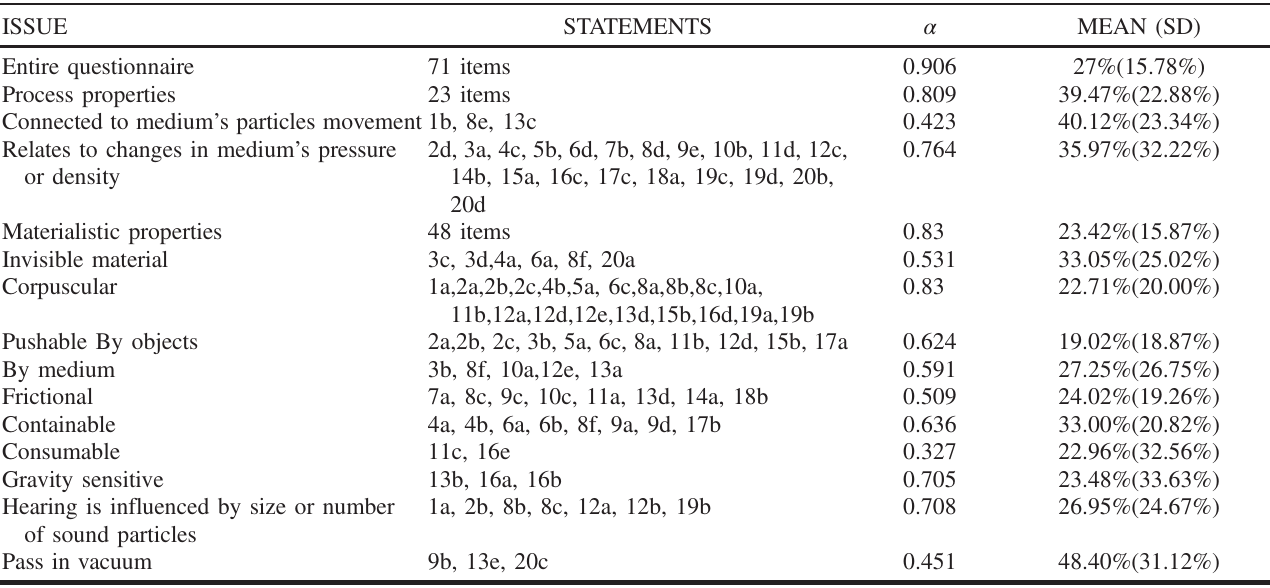
TABLE I. Mean score and alpha Cronbach for the entire questionnaire and its subcategories.